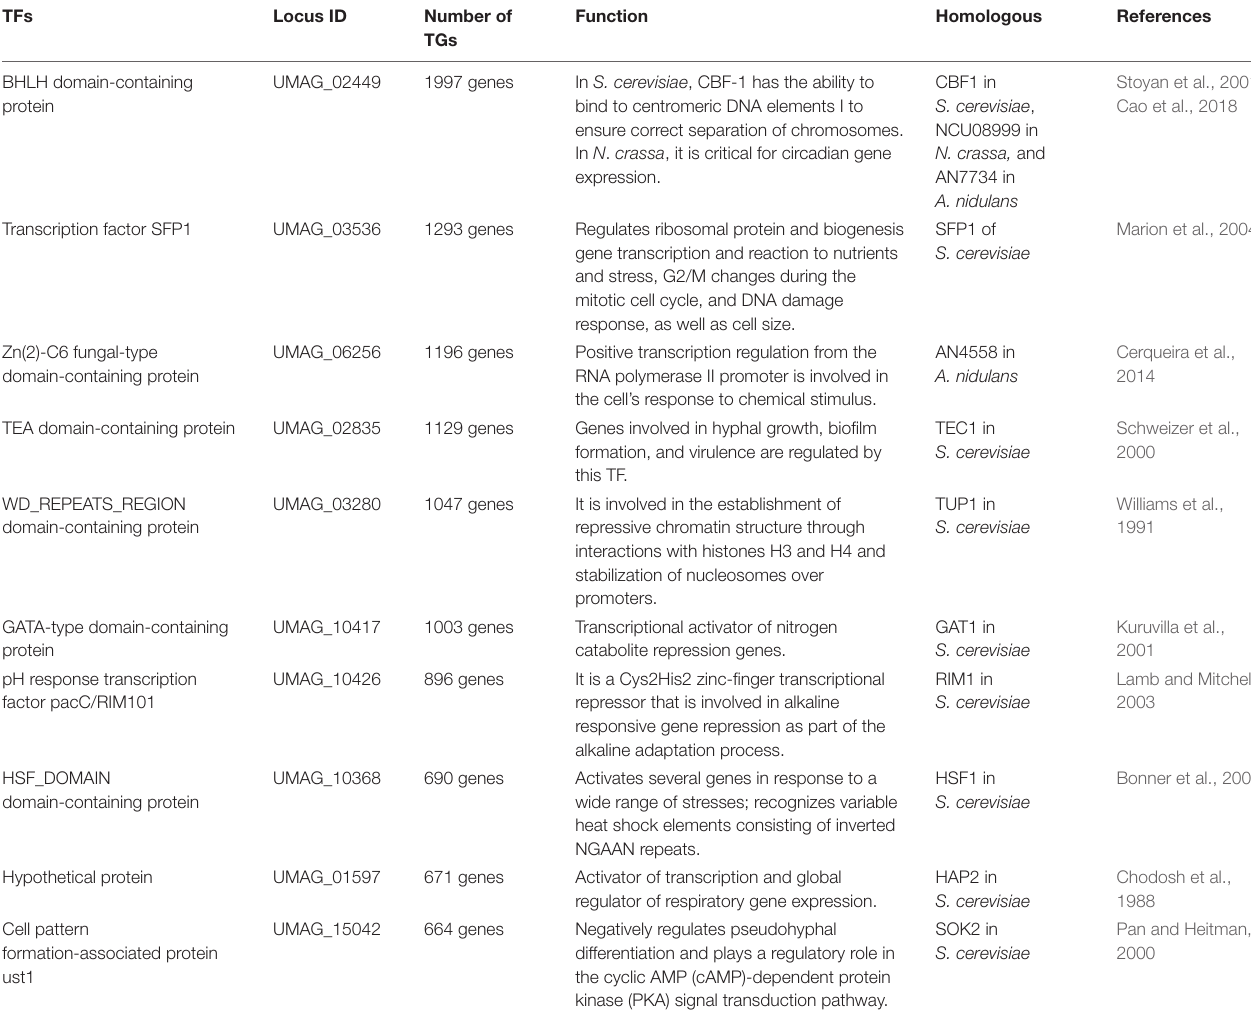
TABLE 5 | Identified hubs in the reconstructed